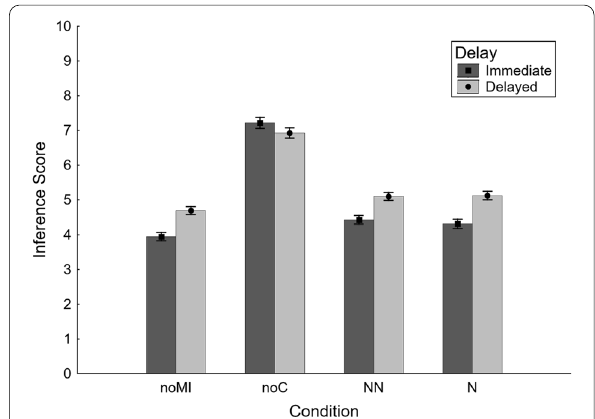
Fig. 1 Mean inference scores across conditions in Experiment 1. noMI, no-misinformation; noC, no correction; NN, non-narrative; N, narrative. Greater values indicate greater misinformation reliance. Error bars indicate within-subjects standard error of the mean (Morey